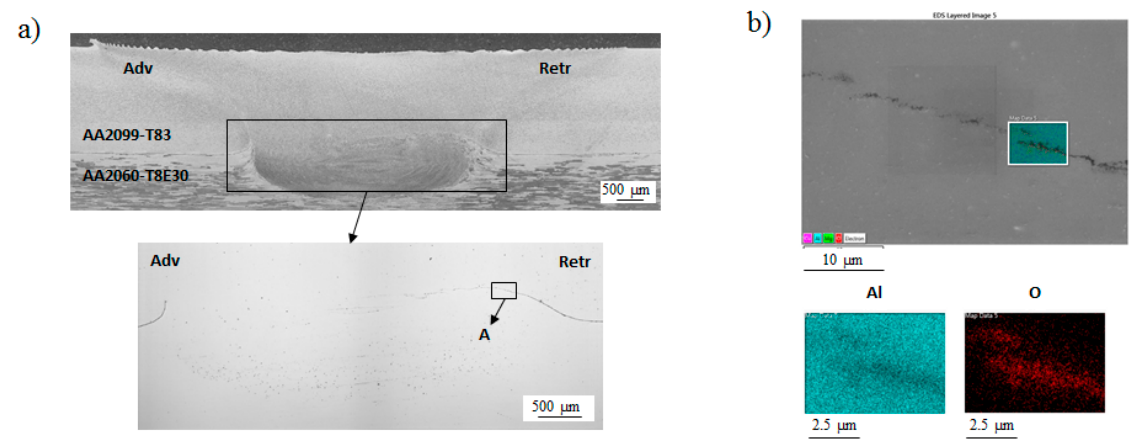
Figure 7. ( a ) Cross-sectional macrograph of the FSW weld from coupon C1 and ( b ) SEM image and EDS analysis of the region indicated as detail A in Figure 7a.